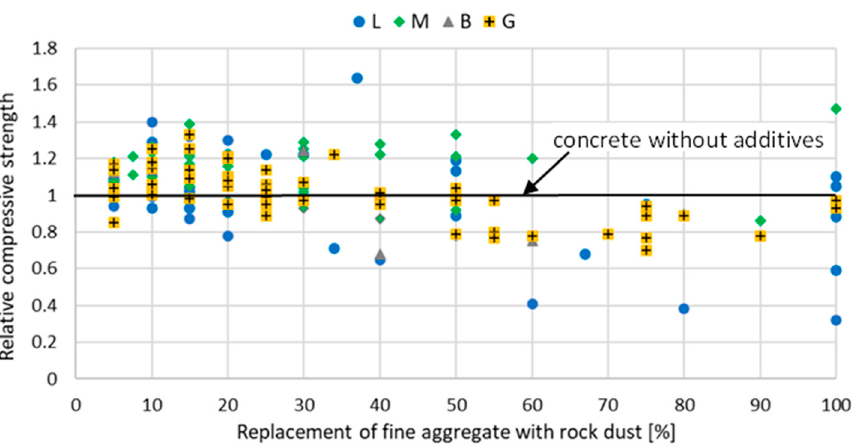
Figure 5. The effect of replacing fine aggregate with rock dust on the compressive strength of concrete after 7 days of curing: limestone dust (L) [13,33,91,92,98,99], marble dust (M) [12,30,33,34,61,93,94,100–103], basalt dust (B) [56,104,105], granite dust (G) [54,106–110].